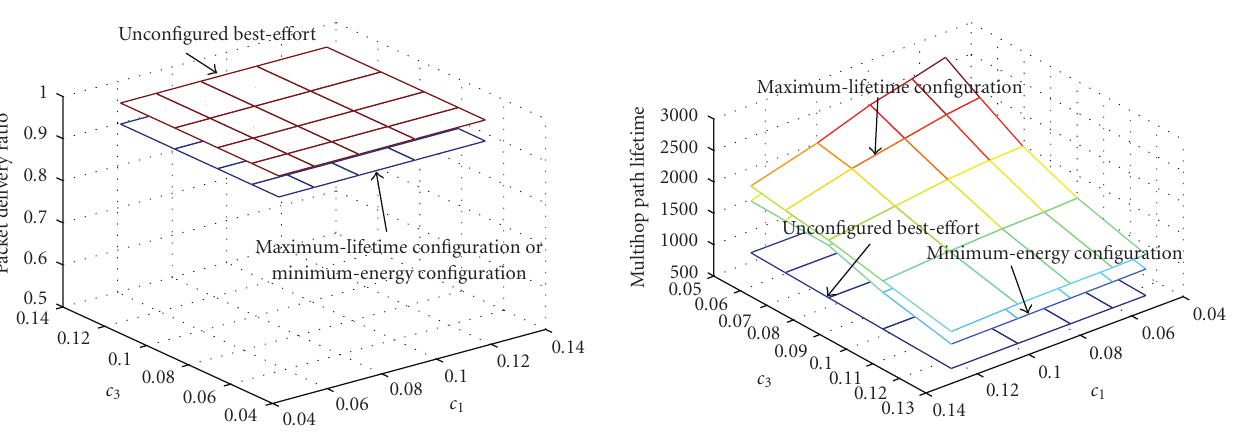
Figure 2: Packet delivery ratio with the maximum-lifetime config- uration, minimum-energy configuration, and unconfigured best- e ff ort strategies ( P req = 0 . 95, N = 11, p max = 0 . 56W).